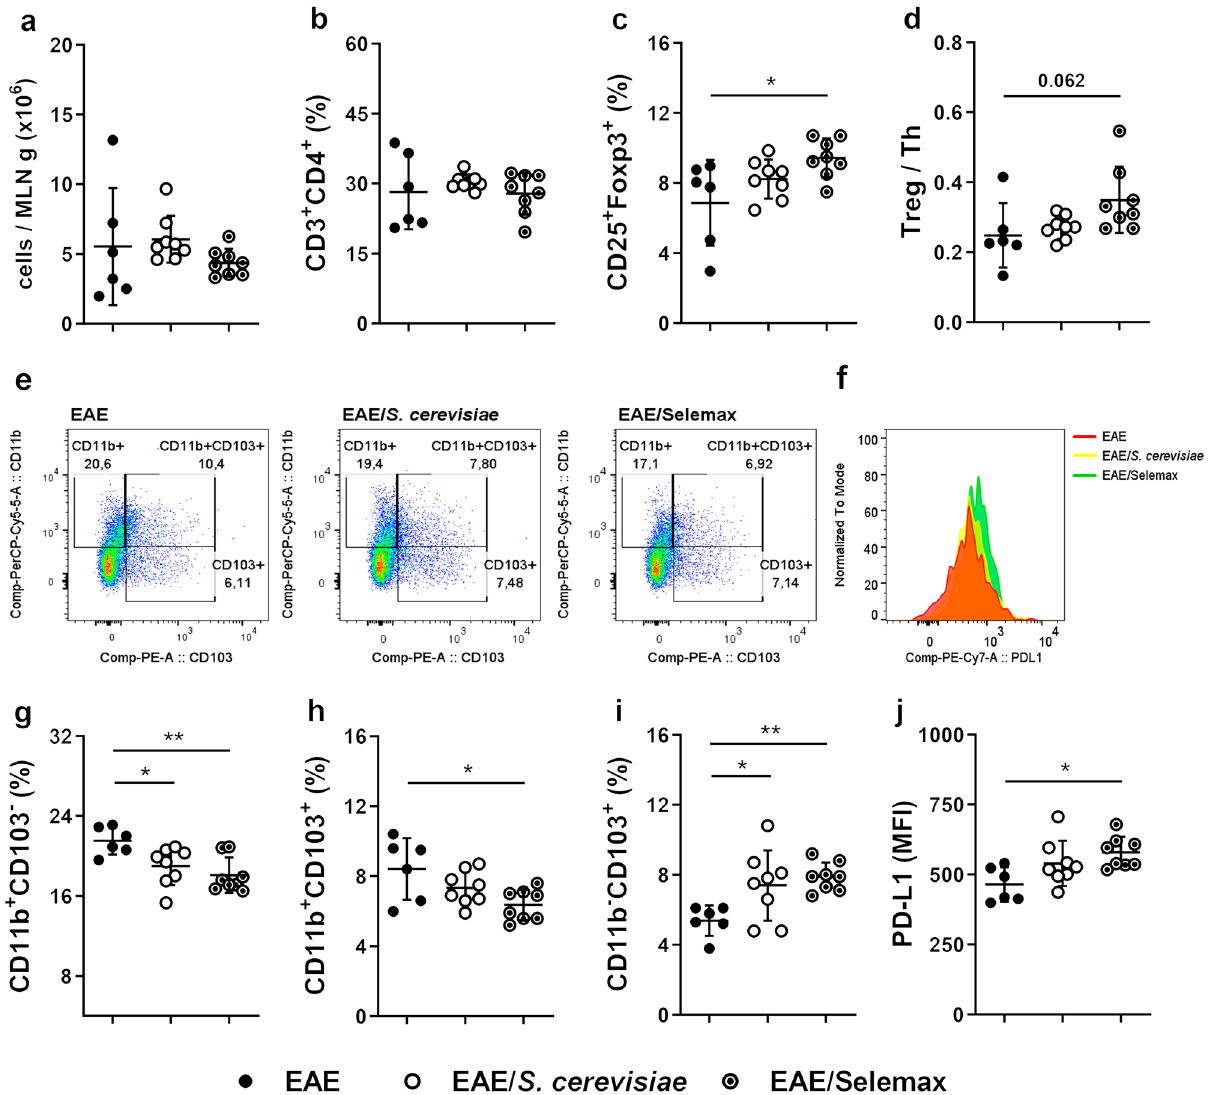
Figure 5. Effect of S. cerevisiae and Selemax on the proportion of Tregs and tolerogenic DC in mesenteric lymph nodes. EAE mice received 14 oral doses of S. cerevisiae or Selemax. Total number of leukocytes present in mesenteric lymph nodes (MLN) per gram of tissue ( a ). Total cells from MLN were collected and analyzed by flow cytometry to establish the proportion of T helper cells (Th - CD3 + CD4 + ) ( b ) and regulatory T cells (Treg - CD25 + Foxp3 + ) ( c ). The proportion of T subsets was used to calculate the ratio between Treg and Th cells ( d ). Representative gating strategy to assess dendritic cell (DC - CD11c + MHCII High ) subsets in inguinal lymph nodes ( e ) and the mean fluorescence intensity (MFI) of PD-L1 in tolerogenic DC (CD11b - CD103 + ) subset ( f ). The proportion of CD11b + CD103 - ( g ), CD11b + CD103 + ( h ) and CD11b - CD103 + ( i ) DC subsets in total DC. The MFI of PD-L1 was evaluated in CD103 + CD11b - DC subset ( j ). Statistical analysis was performed by one-way ANOVA and subsequent Tukey’s test. All data were expressed as the mean ± SD and statistical differences were represented by * p < 0.05 and ** p < 0.01. Two independent experiments were combined, n = 6–8 mice/group. The graphs were created using GraphPad Prism v.8.0.2, flow cytometry images were created using FlowJo 10.7.1 and image was modified with Adobe Photoshop